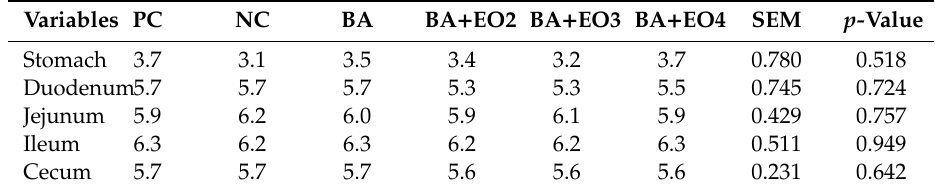
Table 5. E ff ect of experimental diets on the pH of piglets challenged with E. coli F4.